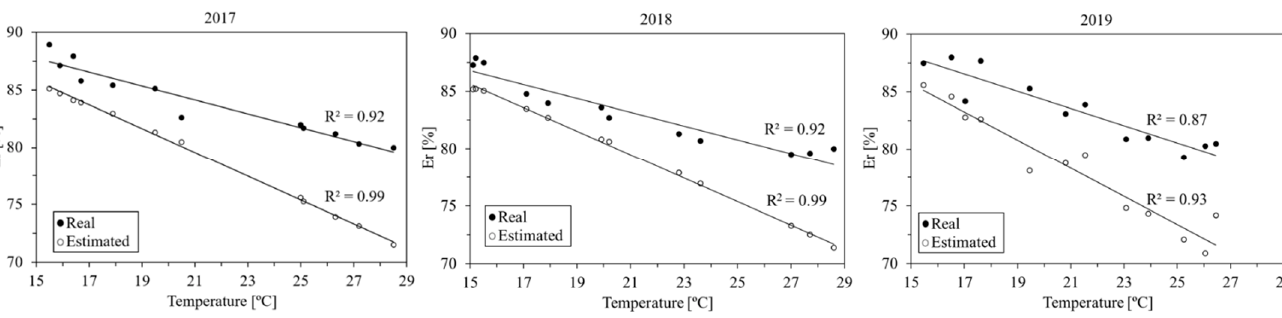
Figure 6. Real values and those estimated with the WAVE software of DUPONT of the boron concentration for permeate water according to the feed water temperature in 2017, 2018 and 2019.